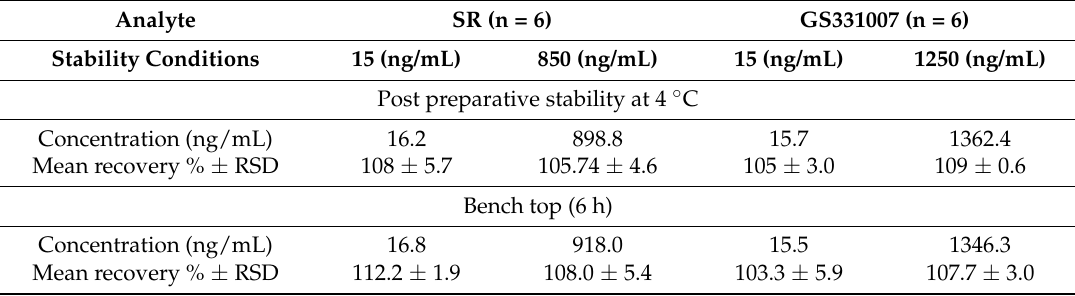
Table 3. Stability of SR and GS331007 in a matrix using the proposed analytical